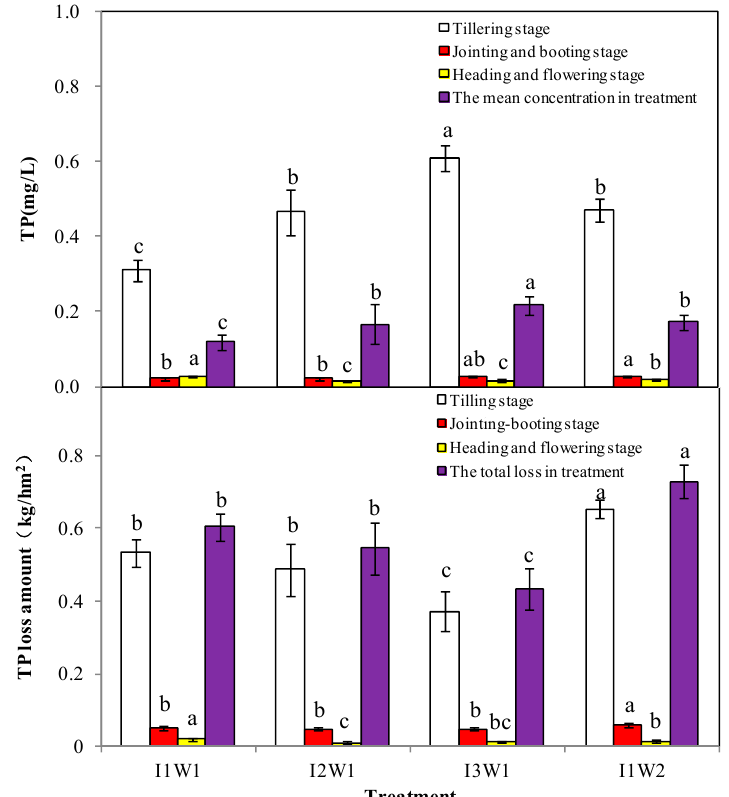
Figure 3. Total phosphorous (TP) losses for surface discharge in di ff erent irrigation treatments. I1W1 represents shallow–frequent irrigation with aquaculture wastewater; I2W1 represents shallow–wet irrigation with aquaculture wastewater; I3W1 represents flooding irrigation with aquaculture wastewater; I1W2 represents shallow–frequent irrigation with fresh water. Data are mean ± SD ( n = 4). The di ff erent letters on the tops of columns indicate significant di ff erences among treatments at 5% according to Duncan’s multiple range